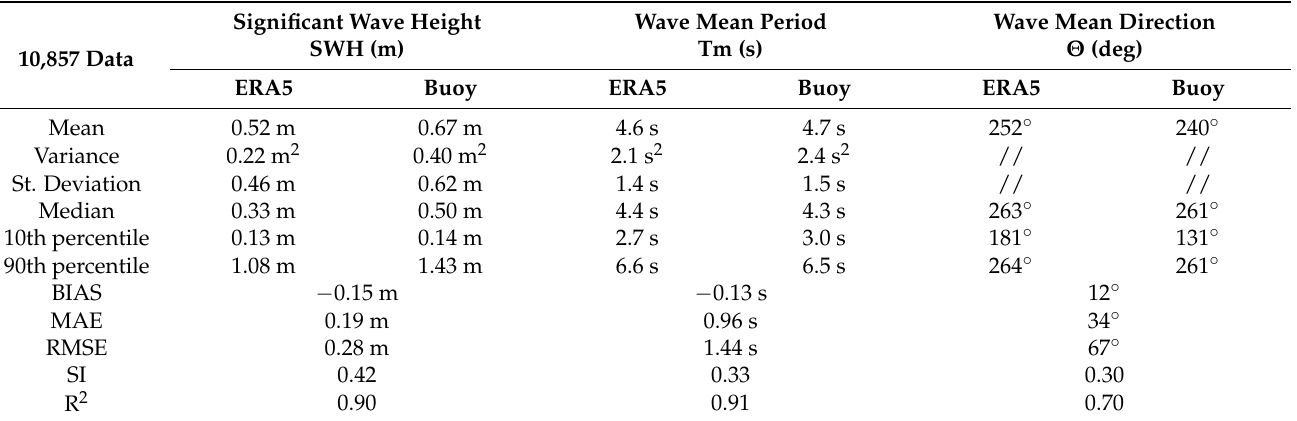
Figure 3. Dataset 27 February 1999–5 April 2008, time step of 6 h. Comparison between ERA5 and buoy observations at Cetraro. Scatter plots of SWH ( a ) and Tm ( b ). Green lines represent the quantile–quantile plots, black lines the bisectors, and red lines the least-square best fits. Table 1. Dataset 27 February 1999–5 April 2008, time step of 6 h. Comparison between ERA5 and buoy data at Cetraro. Statistics parameters and error metrics for SWH, Tm, and θ . Non-significant values are identified with